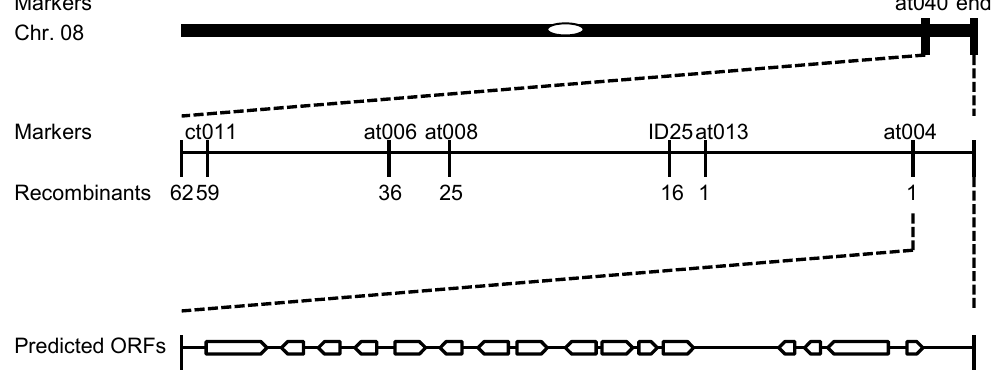
Figure 3. Fine mapping of NWGL . The NWGL locus was mapped onto chromosome C08. Molecular markers and ORFs in the mapping region are shown.